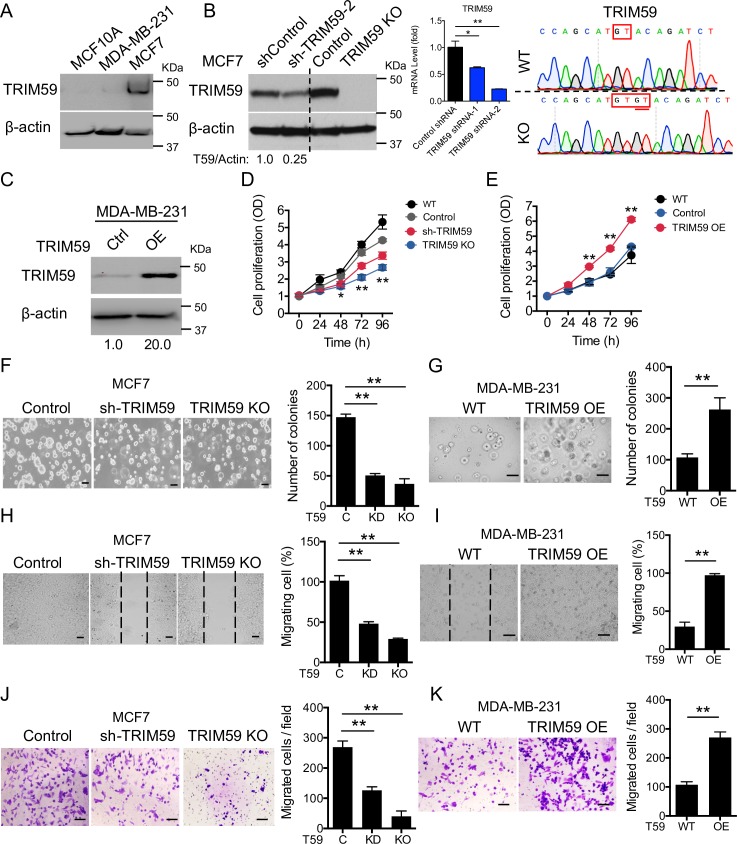
TRIM59 promotes breast cancer cell proliferation, growth, migration, and invasion in vitro.(A) IB analysis of TRIM59 expression in the noncancerous mammary epithelial cell line (MCF10A) and breast cancer cell lines (MCF7 and MDA-MB-231). (B and C) IB analysis of TRIM59 expression in shRNA or CRISPR/Cas9 lentivirus-transduced control, TRIM59 KD (shTRIM59-2, KD efficiency confirmed by qPCR; B, middle) and TRIM59 KO MCF7 (B, left), or TRIM59-overexpressing (OE) MDA-MB-231 stable cells (C). sgRNA targeting TRIM59 was confirmed by Sanger sequencing (B, right). A dinucleotide GT insertion (underlined) caused an early abortion of TRIM59 translation, as further validated by immunoblotting (B, lane 4). (D and E) Graphic representation of 96-hour MTS proliferation assays of WT (non-transduced), control (transduced with non-targeting shRNA/sgRNA), shTRIM59 and TRIM59 KO MCF7 cells (D), and WT or TRIM59 OE MDA-MB-231 cells (E). (F and G) Colony formation assay in 3D Matrigel culture was performed to assess the rate of colony formation of control, shTRIM59, and TRIM59 KO MCF7 cells at day 8 (F) or WT and TRIM59 OE MDA-MB-231 cells at day 4 (G). Bar graphs show the number of colony-forming units (n = 8). Scale bars: 100 μm. (H and I) Scratched wound healing assays were performed to assess the rates of migration for control, shTRIM59, and TRIM59 KO MCF7 cells at 72 hours (H) or WT and TRIM59 OE MDA-MB-231 cells at 36 hours (I). Bar graphs show the percentage of migration rate (n = 8). Scale bars: 100 μm. (J and K) Transwell invasion assay was performed in Matrigel-coated 8-μm pore size transwell plates to assess the invasion ability of control, shTRIM59, and TRIM59 KO MCF7 cells (J) or WT and TRIM59 OE MDA-MB-231 cells (K). Bar graphs show the numbers of invaded cells (n = 8). Scale bars: 100 μm. Data in B, D-K are presented as means ± SD; *P < 0.05, **P < 0.01 versus controls. The underlying data can be found in S1 Data. CRISPR/Cas9, clustered regularly interspaced short palindromic repeats (CRISPR)-associated protein-9 nuclease; IB, immunoblot; KD, knockdown; KO, knockout; MTS, 3-(4,5-dimethylthiazol-2-yl)-5-(3-carboxymethoxyphenyl)-2-(4-sulfophenyl)-2H-tetrazolium; OD, optical density; OE, overexpressing; qPCR, quantitative polymerase chain reaction; sgRNA, single guide RNA; shRNA, short hairpin RNA; TRIM59, tripartite motif 59; WT, wild-type.